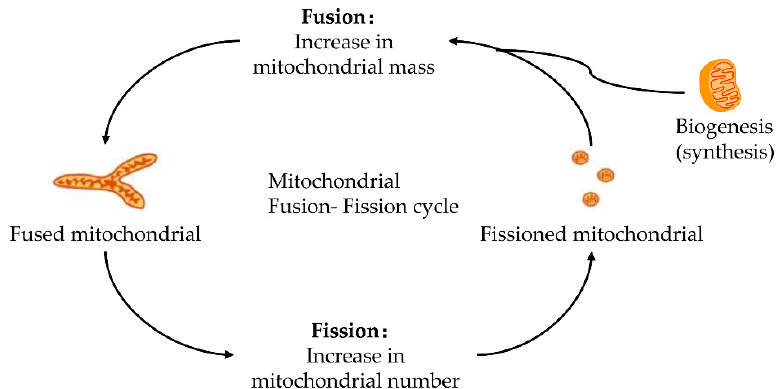
Figure 1. Fusion–fission cycle in mitochondria. Mitochondria strictly control the fusion and fission process through mitotic proteins embedded in the inner and outer membranes to maintain the dy- namic balance of biological energy. The mitofusins and Opa1 mediate the fusion of the mitochondrial membrane. Fusion and fission belong to the mitochondrial quality control cycle. The growth and division of pre-existing mitochondria are also involved.